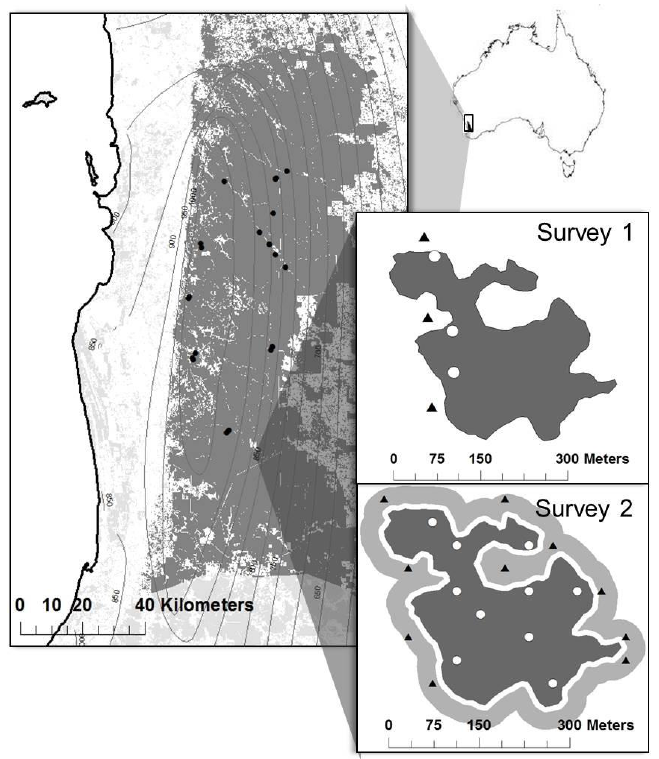
Figure 1. Study site location was the Northern Jarrah Forest of Southwestern Australia. Study sites (black dots) were located in the remaining intact, native vegetation of the forest (dark grey color). Within each study site (inset), three and ten plot locations were randomly selected for severely- (white dots) and minimally-affected (black triangles) forest area for Survey 1 and Survey 2, respectively. The discrete nature of the damage allowed for sampling both severely and minimally drought-affected forest in close proximity. A 10 m forest area buffered severely from minimally-affected